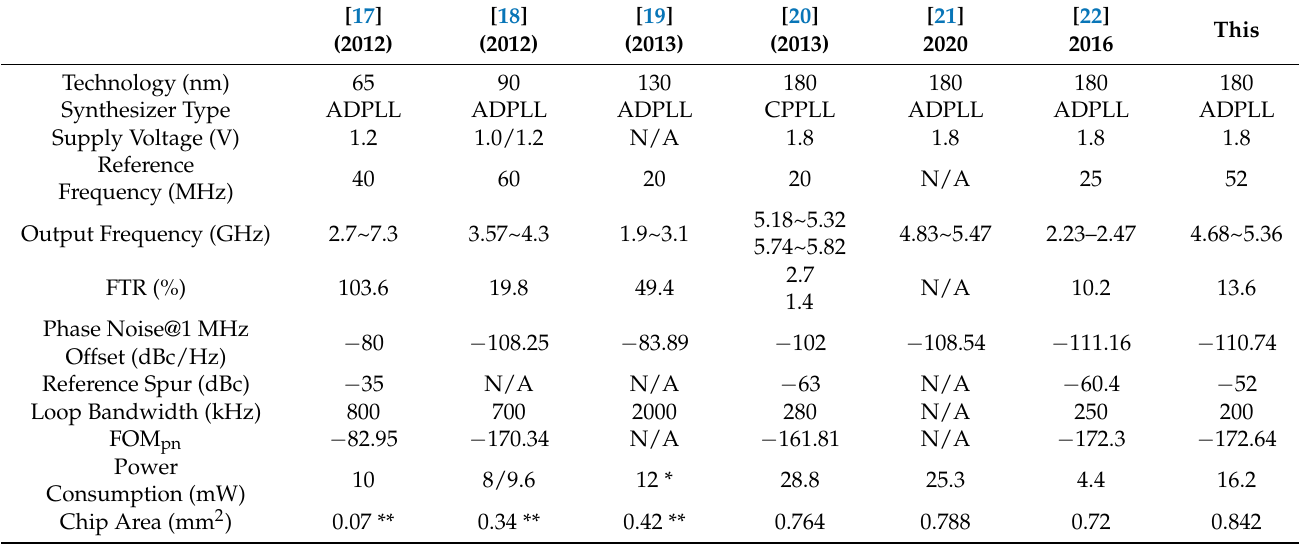
* current consumption (mA) ** core area (mm 2